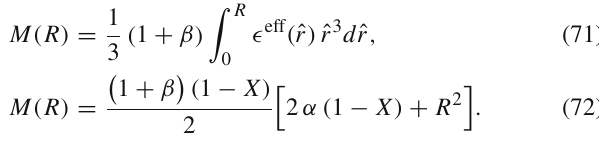
Fig. 6 Variation of effective anisotropy ( (cid:17) eff ) versus radial coordinate r / R . The left figure is plotted for fixed β = − 0 . 6 with different α while right figure for fixed α = 5 with different β